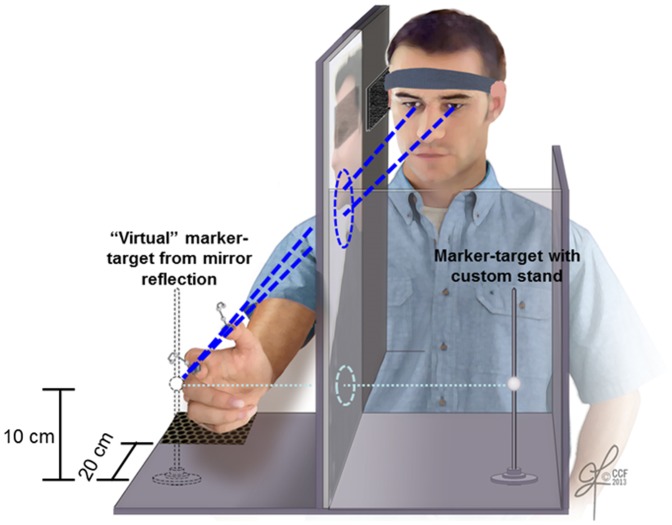
Subject performs reach-to-pinch maneuver towards “virtual” target with no visual feedback of moving hand and grasping digits.